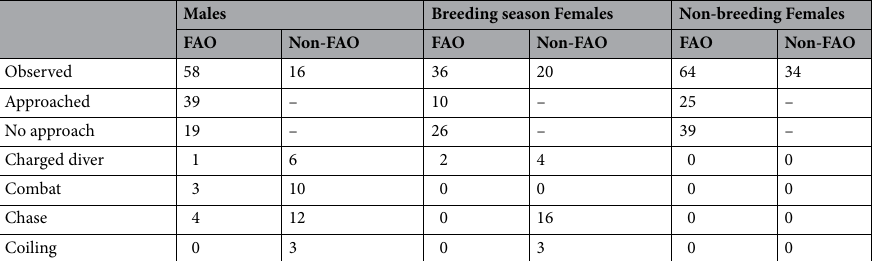
did not differ significantly between breeding and non-breeding seasons (respectively, 10 of 36 encounters vs. 25 of 64 encounters; P = 0.28). Removing data for snakes that were inactive did not change these inferences (male vs. female, P < 0.001; breeding vs. non-breeding females, P = 0.08). Of snakes that approached the diver, males were more likely to do so repeatedly during the 30-min focal observation period, whereas most females only did so once (using data on mean number of approaches per indi- vidual [20 males, 34 females] to avoid pseudoreplication: Z = 3.274, P < 0.001; Fig. 2a). Hence, males cumulatively spent longer interacting with the diver over the course of the 30-min observation period than did females (using